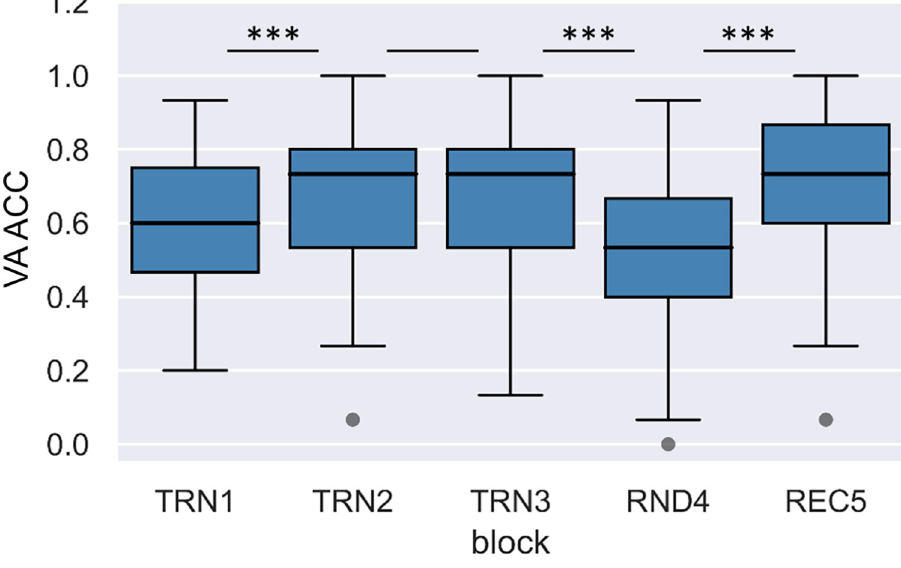
Fig 4. Accuracy rates across blocks in the verbal acoustic condition. Boxes indicate accuracy data between the first and third quartiles, horizontal lines indicate medians, and whiskers illustrate the range of data, and individual dots outside the range represent